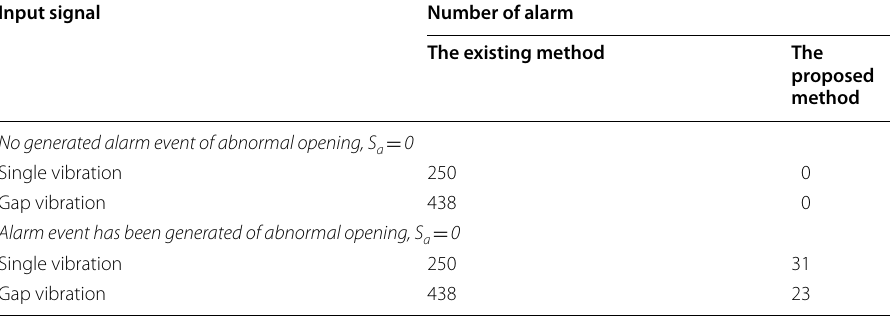
Table 3 Comparison of number of the alarms for the violent opening Input